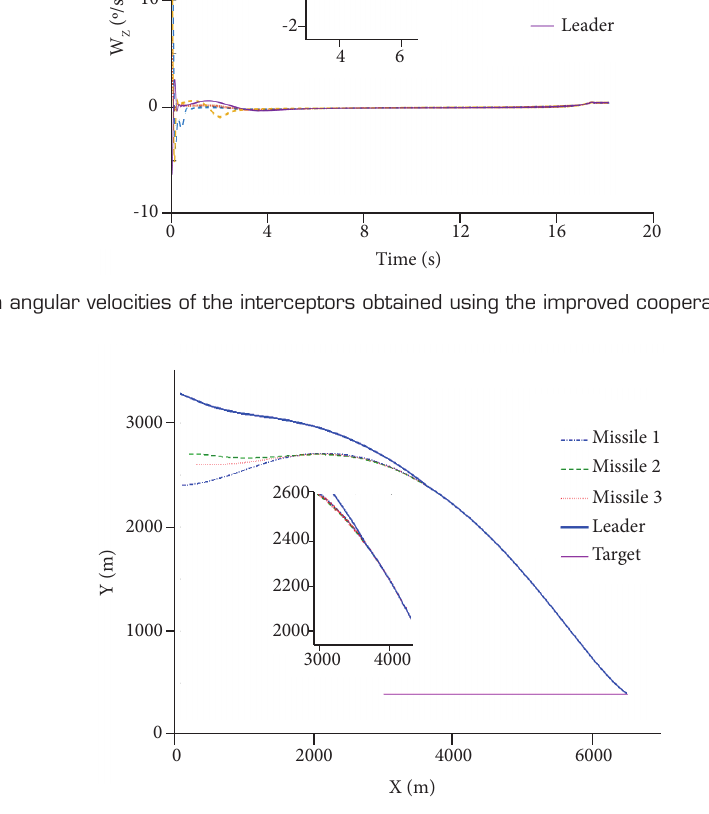
Figure 8. Trajectories of the interceptors and target obtained using the regular cooperative control